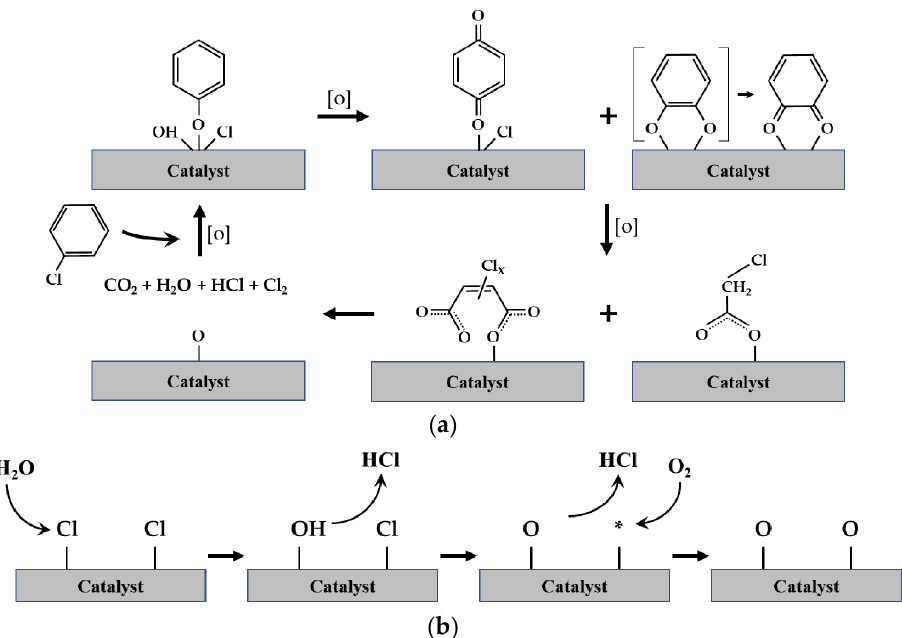
Figure 5. ( a ) Oxidation and ( b ) regeneration of catalysts by the H 2 O mechanism of CVOCs.